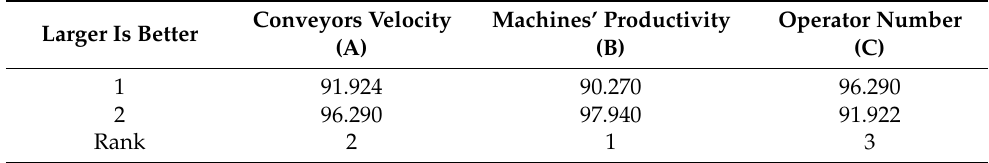
Table 13. Average SNR for Each Factor Level.